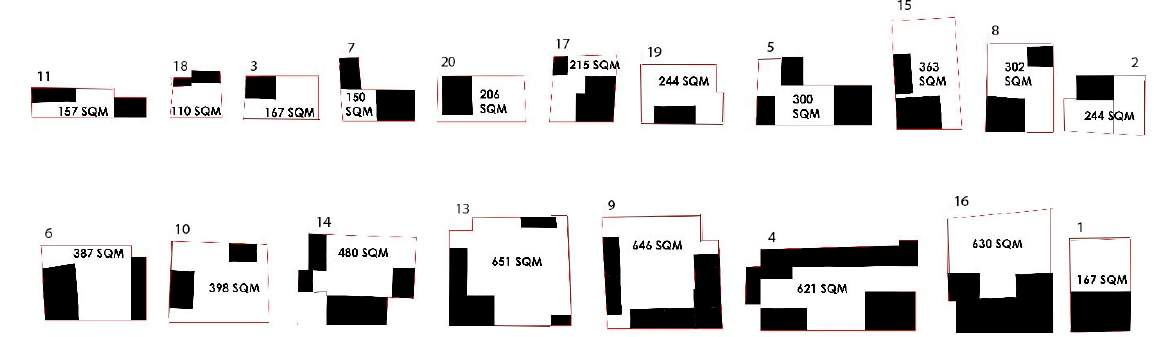
Figure 11. Compound houses arranged according to areas.